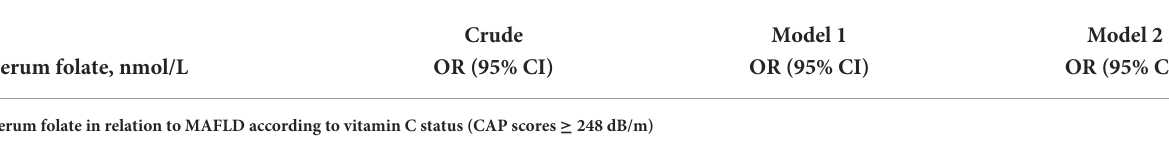
Associationsbetweenserum folate level and MAFLD (CAP scores ≥ 274 dB/m)